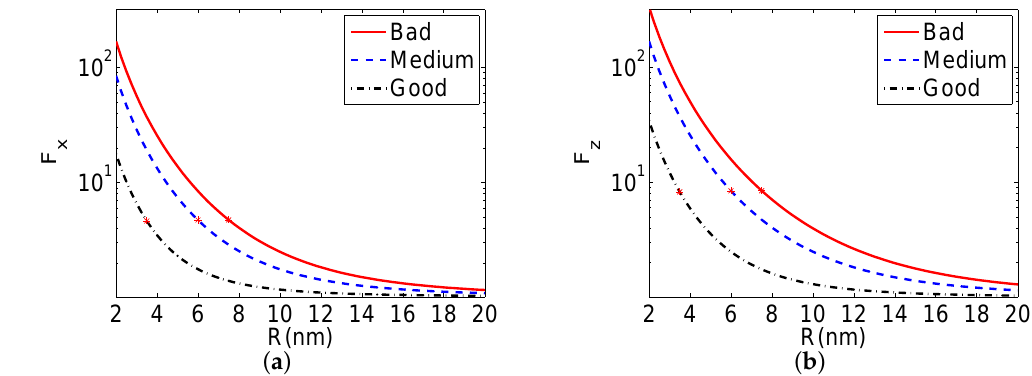
Figure 2. The distance dependence of the Purcell factors for ( a ) x - and ( b ) z -orientations of the transition dipole moment. R is the distance between the QD and the MoS 2 monolayer, for three qualities of the semiconductor material: good (black dashed-dotted line), medium (blue dashed line), and bad (red solid line). The red stars highlight the values for the three examples of Figure